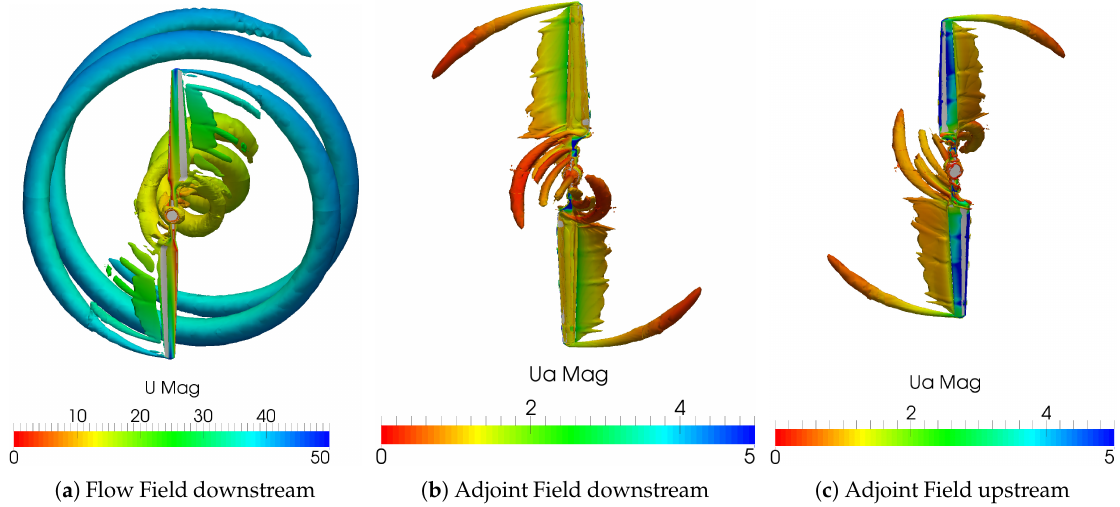
Figure 4. Field visualisation based on the Q-criterion in terms of vorticity. The full rotor for the flow field in ( a ) and for the adjoint field in ( b , c ) is shown. For good comparability, the adjoint field is shown in ( b ) in the same direction, as the flow field, i.e., downstream. As it moves upstream, it is secondly shown in the direction of the propagation of the adjoint field in ( c